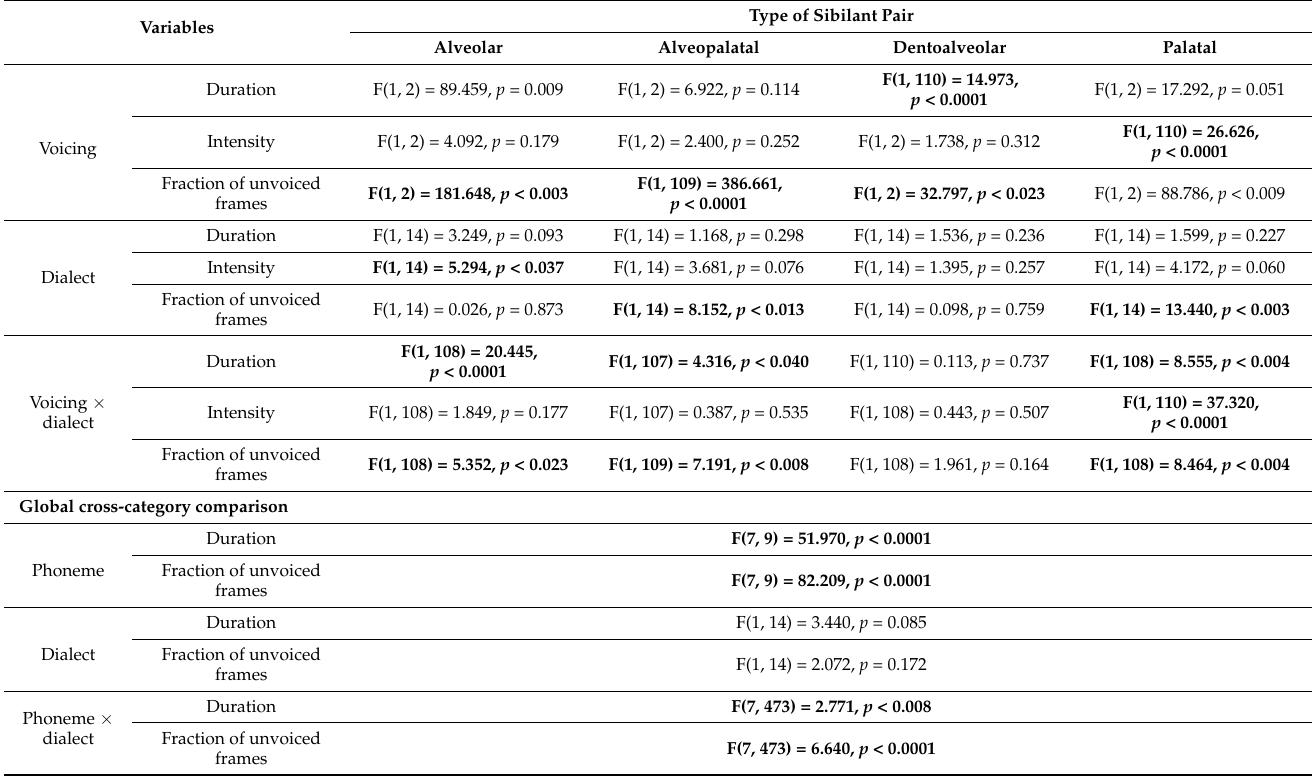
Table 3. Generalized mixed-effects linear model results for each sibilant pair and in cross-category comparation. Significant results are in bold.